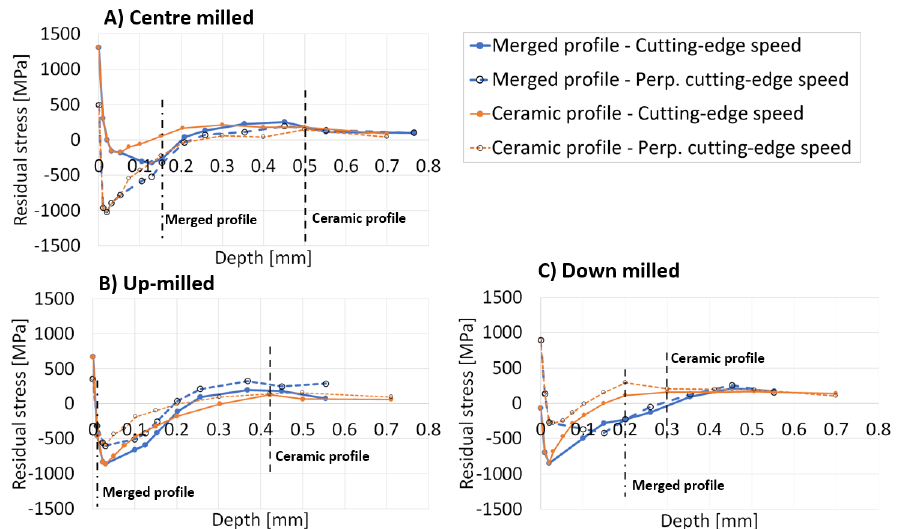
Figure 11. Ceramic and evolution (envelope) profiles, ceramic and 50 µm CC milling at different locations across the slot.